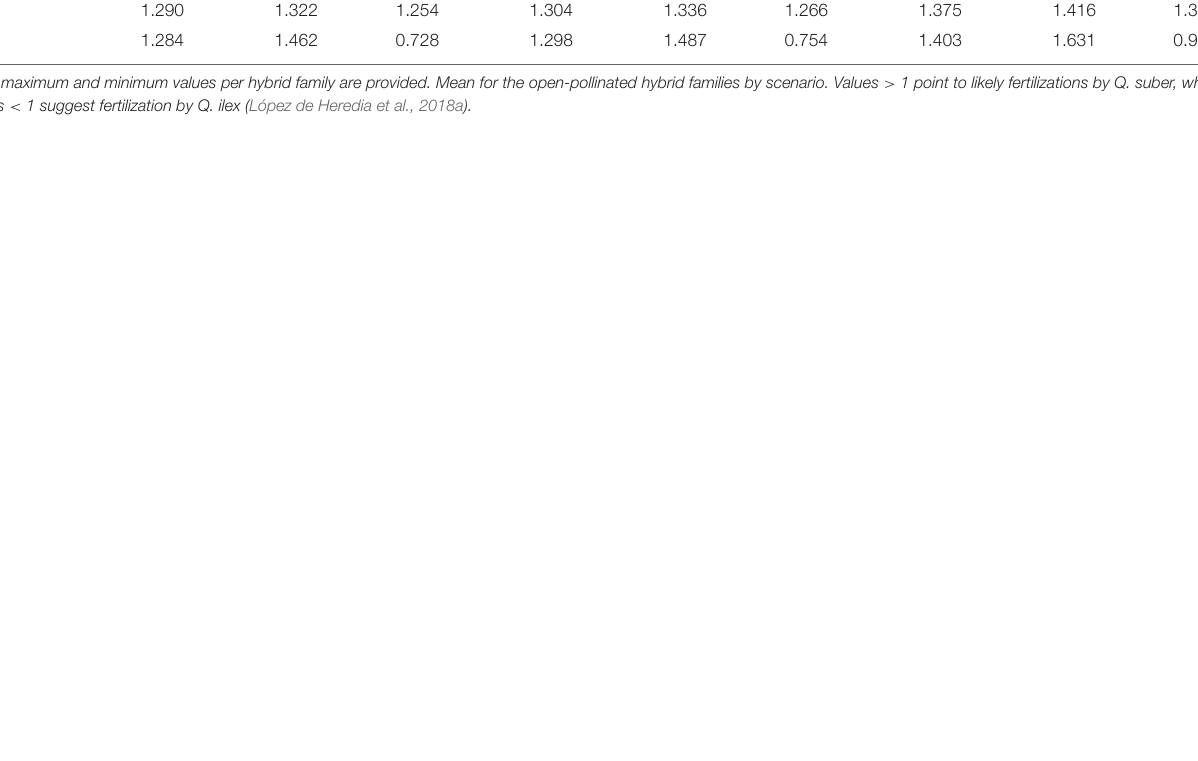
TABLE 3 | Ratio between STRUCTURE’s q s of the offspring and q s of their mothers under each scenario. Mother